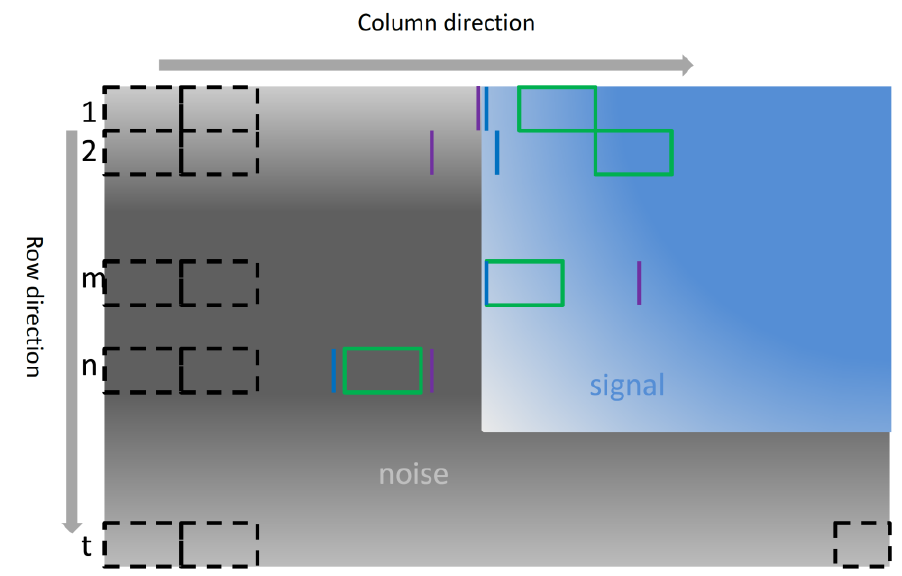
Figure 4. Sketch plot for edge detection process. This figure shows the process of edge detection from the left boundary of an image. The black dashed rectangle indicates a searching image patch. The green rectangle indicates the first patch fulfilling a normal distribution. The blue line indicates the start location ( ET1 in context) where a searching unit firstly crosses a threshold. The block dashed square indicates searching tracks. The purple line indicates the starting location ( ET2 in context) for the maximum of gradient change along the column direction. In this figure, the black color shows regions of poor-quality data and the blue color shows e ff ective backscattered signals. ‘1’, ‘2’, ‘m’, ‘n’, and ‘t’ stand for di ff erent searching units. A searching unit corresponds to all signals from 10 rows of a processing image. The black margin (BM) edge detection from searching units ‘2’, ‘m’, and ‘n’ is not accepted but is accepted from ‘1’. However, in searching unit ‘t’, no edge is detected.